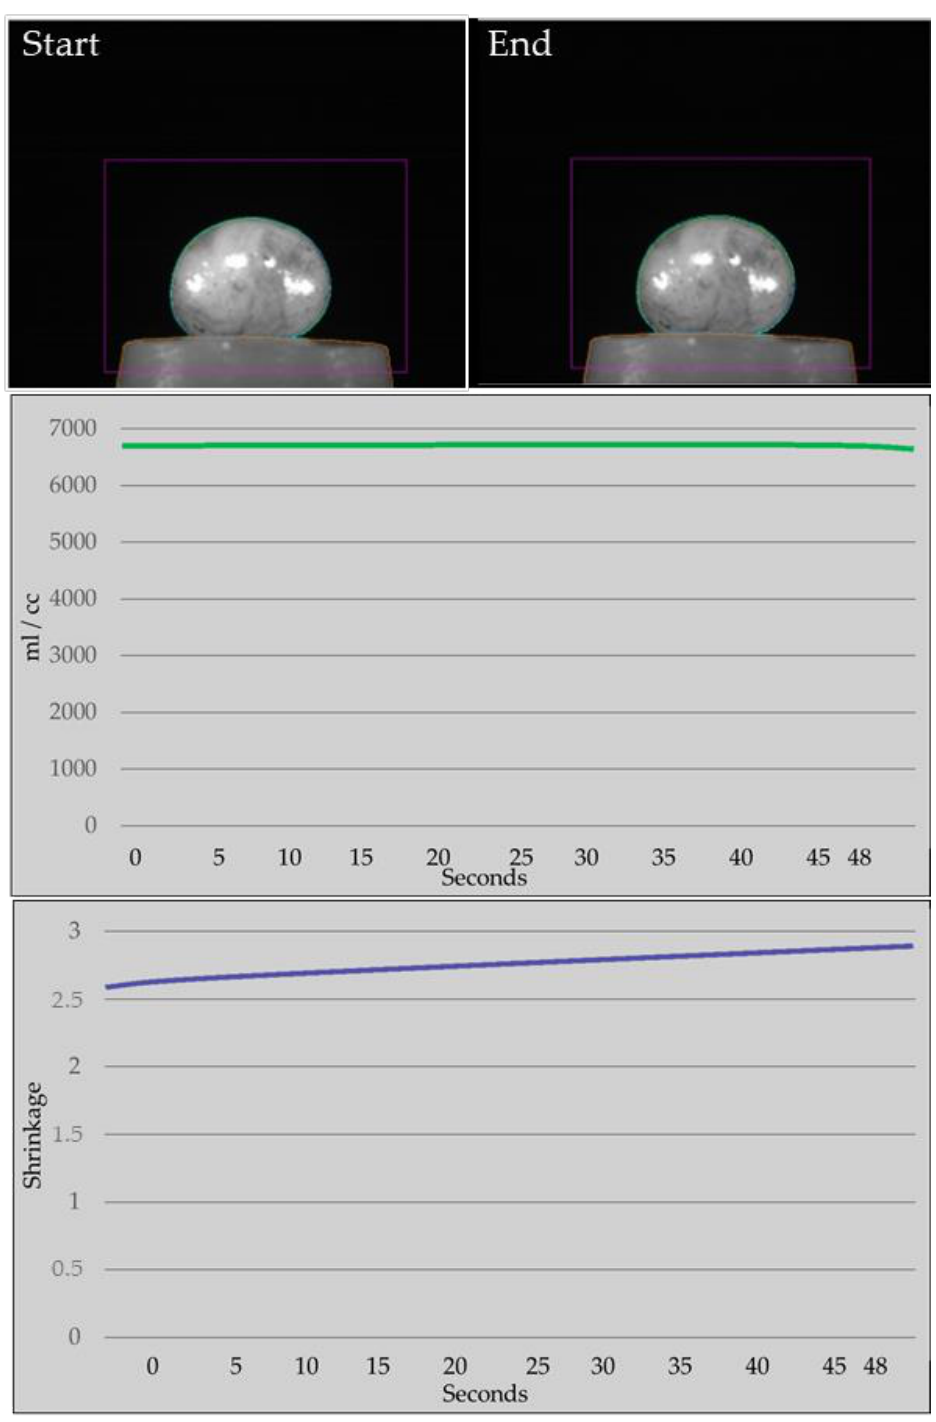
Figure 4. Analysis of images before and after polymerization. The graphs show the shrinkage by time.